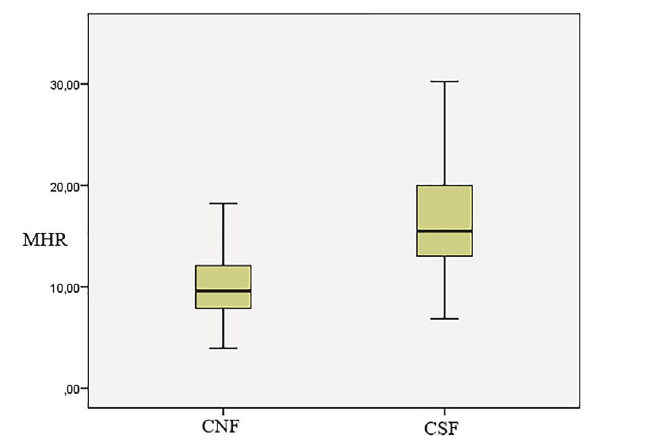
Figure 1a - The comparison of GHR values between the groups Figure 1b - The comparison of MHR values between the